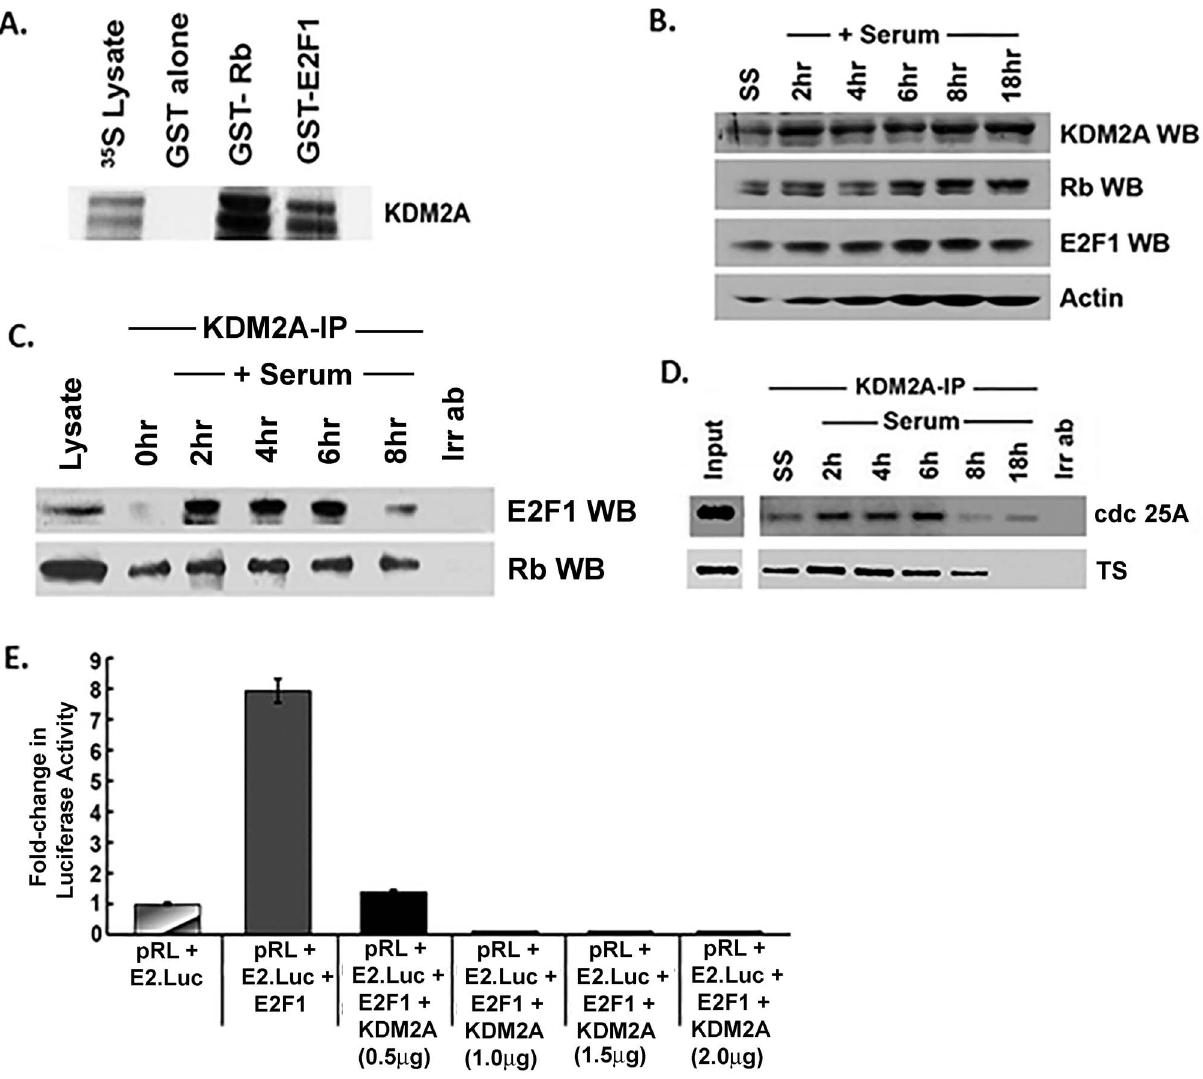
Figure 5. KDM2A interacts with Rb and E2F1 in a cell cycle specific manner. (A) GST pull down assay showing KDM2A binding to Rb and E2F1 in vitro . 35 S-lysate lane has 1/10 th protein loaded. (B) MCF-7 cells were serum starved for 48 hr and serum stimulated for 2 hr, 4 hr, 6 hr, 8 hr and 18 hr. Western blotting showing protein expression of KDM2A, Rb, E2F1 and actin. There is no significant change in the expression of KDM2A and E2F1 at different time points when normalized to actin levels. Rb shows increasing hyperphosphorylation from 6 hr to 18 hr of serum stimulation. (C) KDM2A interacts with Rb and E2F1 in vivo in MCF-7 cells as seen by immunoprecipitation-western blot experiment. Interaction of KDM2A with E2F1 decreases at 8 hr of serum stimulation. (D) Chromatin Immunoprecipitation (ChIP) assays showing KDM2A occupancy on E2F1-regulated proliferative promoters, CDC25A and TS. KDM2A occupies the promoters at all time points from 0 hr to 6 hr, reduction is seen at 8 hr and complete absence of KDM2A from the promoters is observed at 18 hr of serum stimulation. (E) KDM2A significantly represses E2F1-mediated E2.Luc transcription in a dose-dependent manner in Renilla luciferase assay.